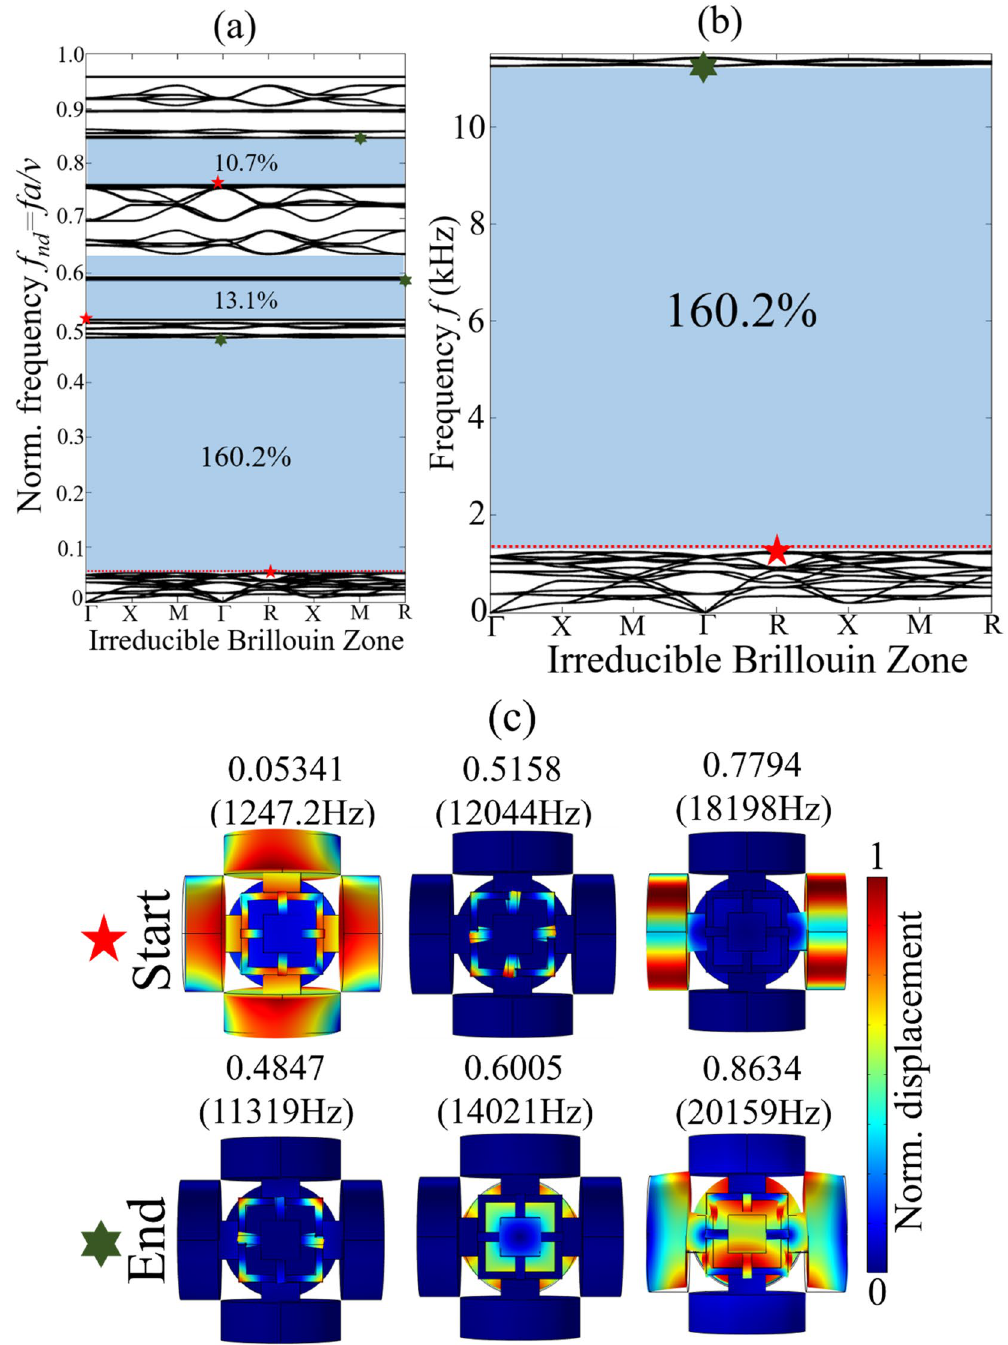
Figure 2. Prototype 1- numerical dispersion spectra: ( a ) complete band structure with normalized frequency; ( b ) the widest first BG with �ω/ω c of 160.2%; ( c ) vibration modes corresponding to the lower and upper bounding edges of